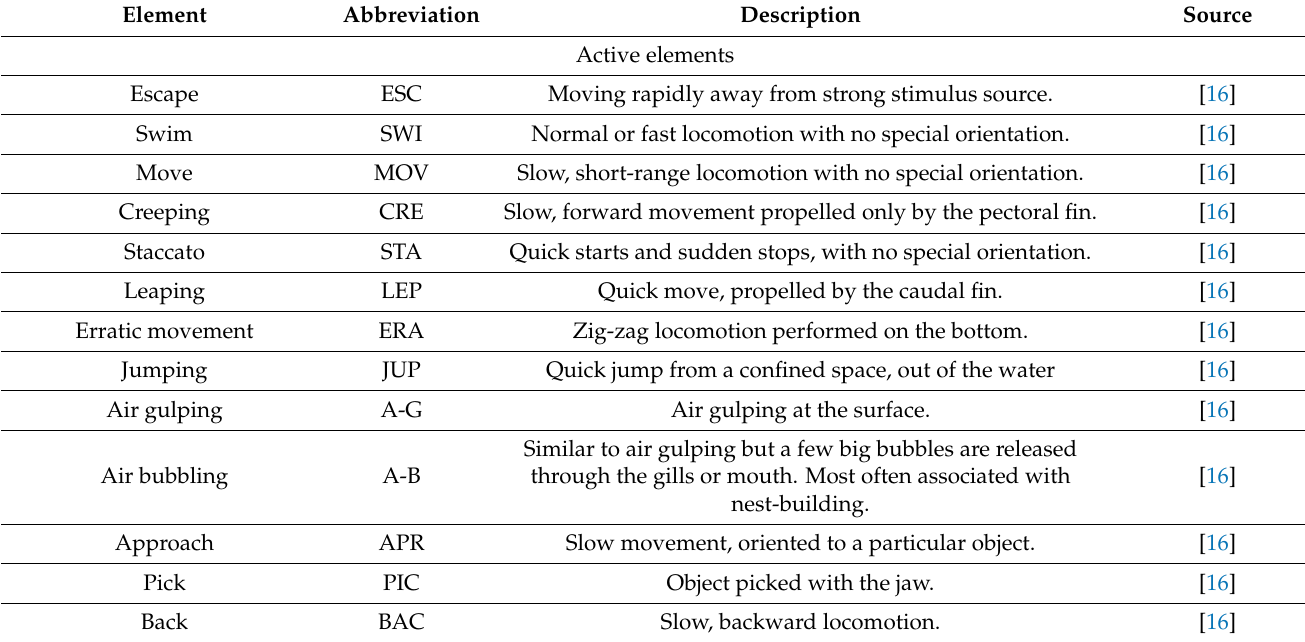
Table A1. A list and short behavioral description (ethogram) of the most common behavioral elements in paradise fish. Element Abbreviation Description Source Active